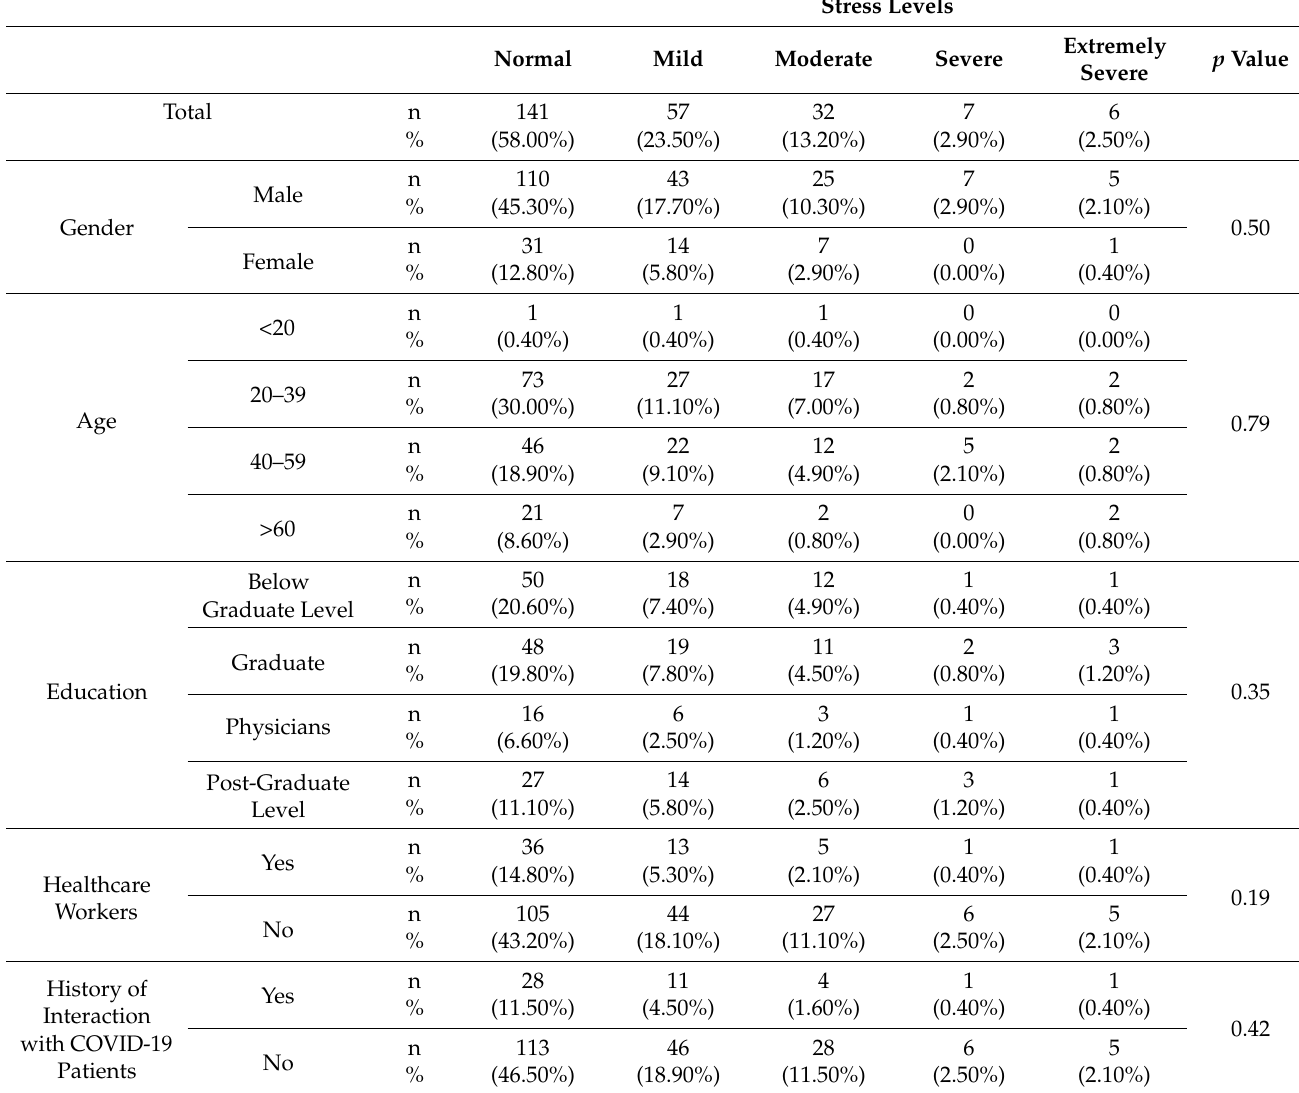
Table 3. Percentage distribution of demographics and stress